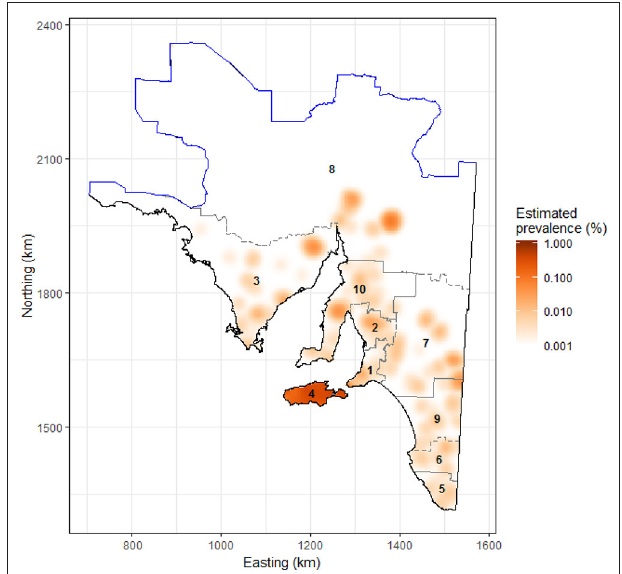
FIGURE 2 | Raster image showing the estimated prevalence of sarcocystosis in sheep > 2 years of age submitted to the Thomas Foods International slaughterhouses in South Australia, 2007–2017. Data were log-transformed for plotting to facilitate detection of high- and low-risk areas, as the estimated prevalence of sarcocystosis on the mainland is relatively low. The solid blue line represents the dog fence and outlines the northern and western boundary of the study region; the gray dashed line delineates the farm identification code regions/numbers as listed in Tables 2 , 3 . Map projection is EPSG: 3107 South Australian Lambert, GDA